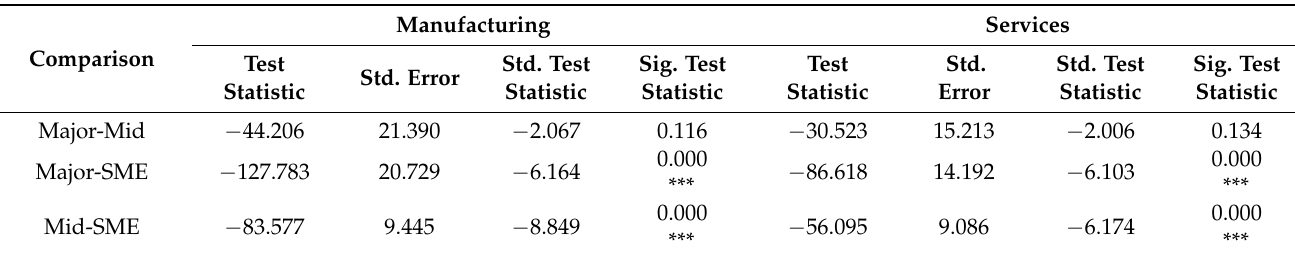
Table 5. Pairwise comparison of ICT manufacturing and service